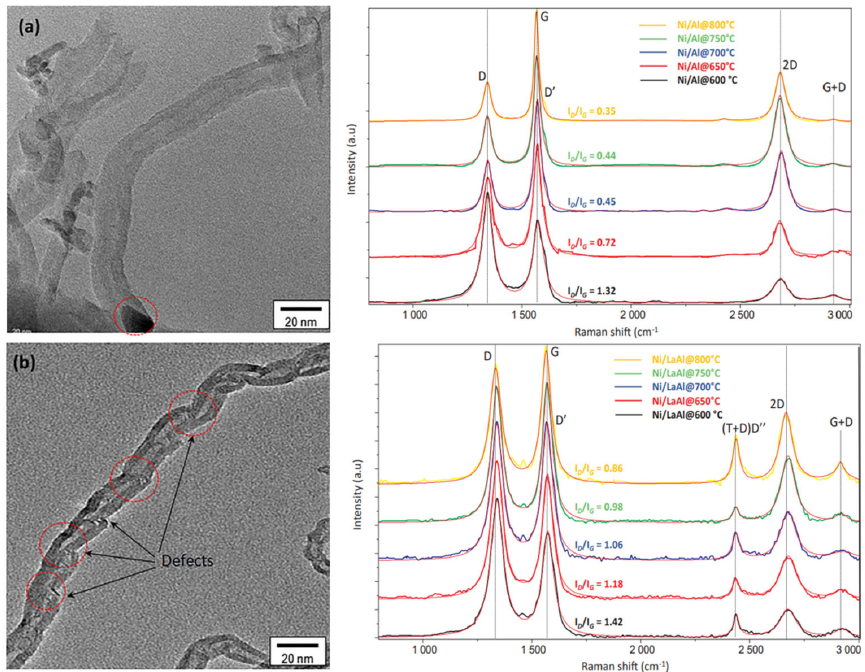
Figure 12. HR ‐ TEM images of spent Ni/Al ( a ) and Ni/LaAl ( b ) catalysts, and their Raman spectra 75. Reprinted with permission from Ref. [77]. Copyright 2019 Elsevier.